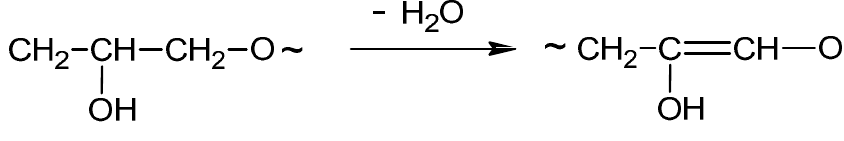
Table 2. Interpretation of MALDI-TOF spectrum of polyol (CS + H 2 O +GL) + EC.